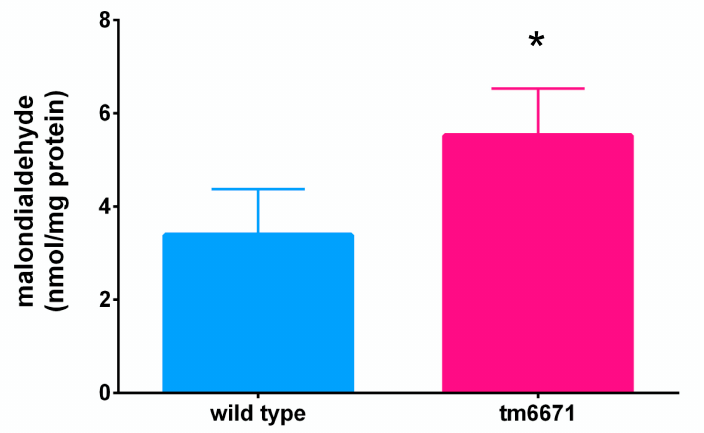
Figure 6. MDA level in the tm6671 mutant worms. MDA level was measured as described in Materials and Methods. All values represent mean ± SD of seven independent experiments. Asterisks indicate that the values are significantly different from those of the N2 worms ( p < 0.05).